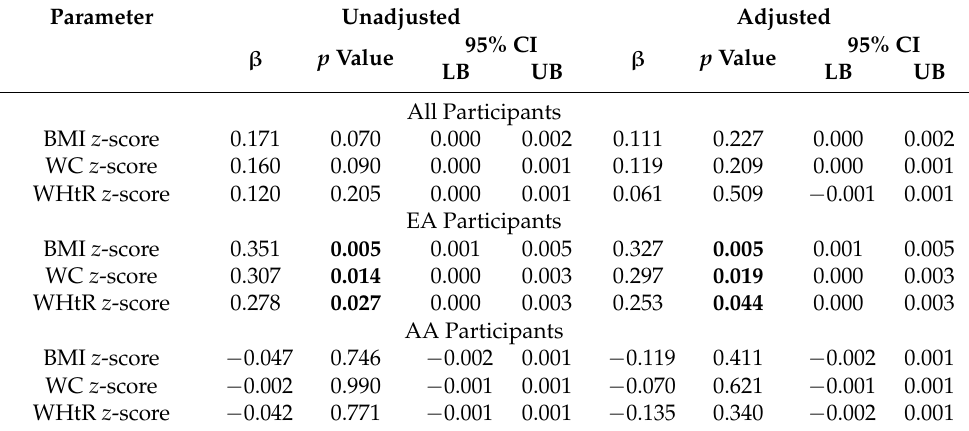
Table 6. Hierarchical regression analysis of obesity measures and PMR of FTO